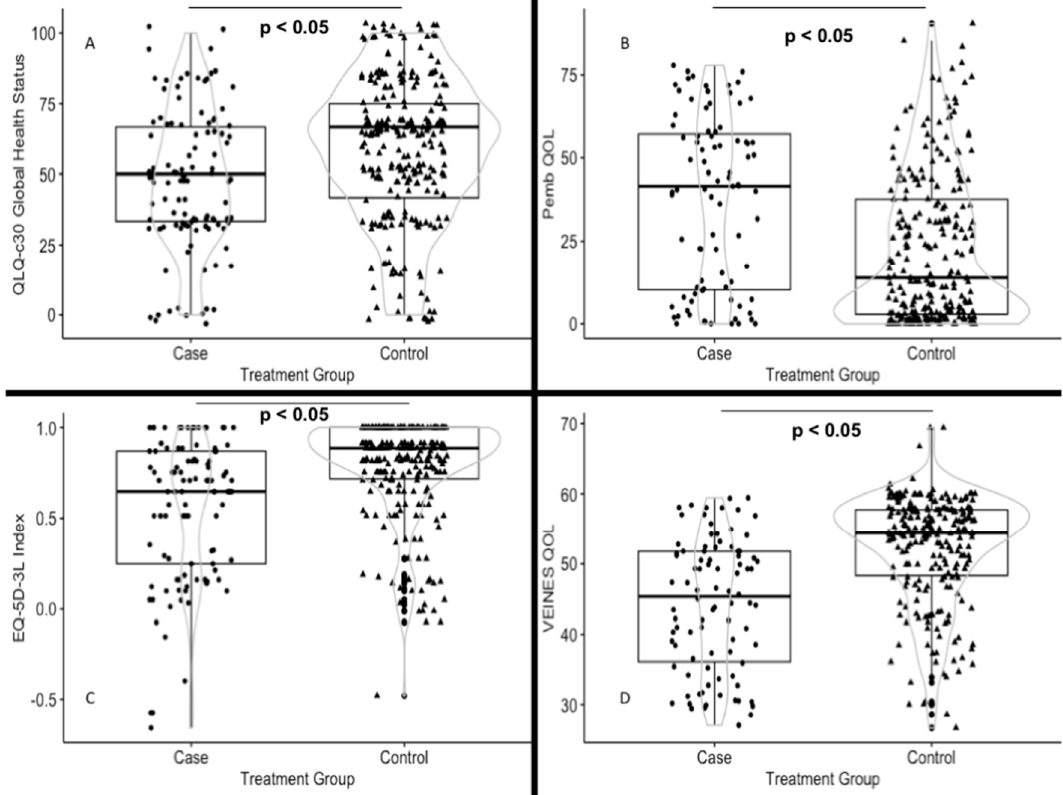
Figure 1. Cases and controls distribution of the data and its probability density in different questionnaires. Violin plots. ( A ) QLQ-c30 Global Health Status, ( B ) Pemb-QOL, ( C ) EQ-5D-3L Index, and ( D ) VEINES QOL. The plots show the actual distribution of the observed values (dots in cases and triangles in controls), ultimately allowing a representation of the scores used in the study. Boxplots depicts the median (black line inside the box) and the interquartile range (the edges of the box). The kernel density plot (grey line) represents the probability density function. Larger sections of the violin plot indicate a higher probability of observation at a given value, whereas thinner sections correspond to a lower probability.